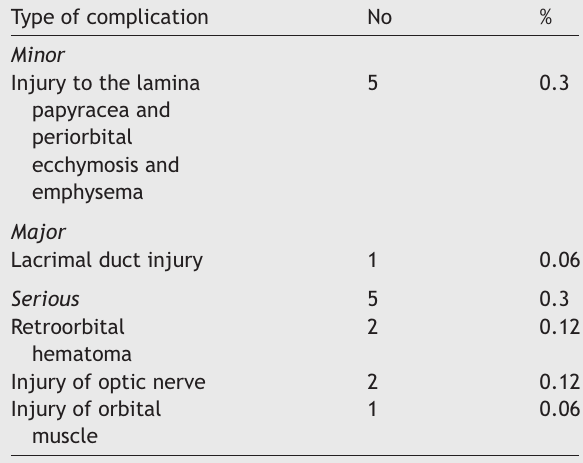
Rate of ophthalmic complications in total